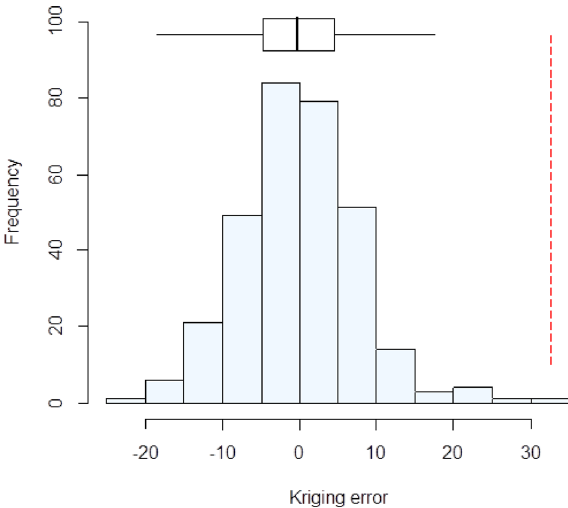
Figure 2. Histogram of the cross-validation errors using the variogram fitted to estimates obtained with the Matheron (1962) estimator 23 . The Box-plot shows the median and quartiles (box limits). The vertical dashed line shows the outer fence values of Tukey (1977) 25